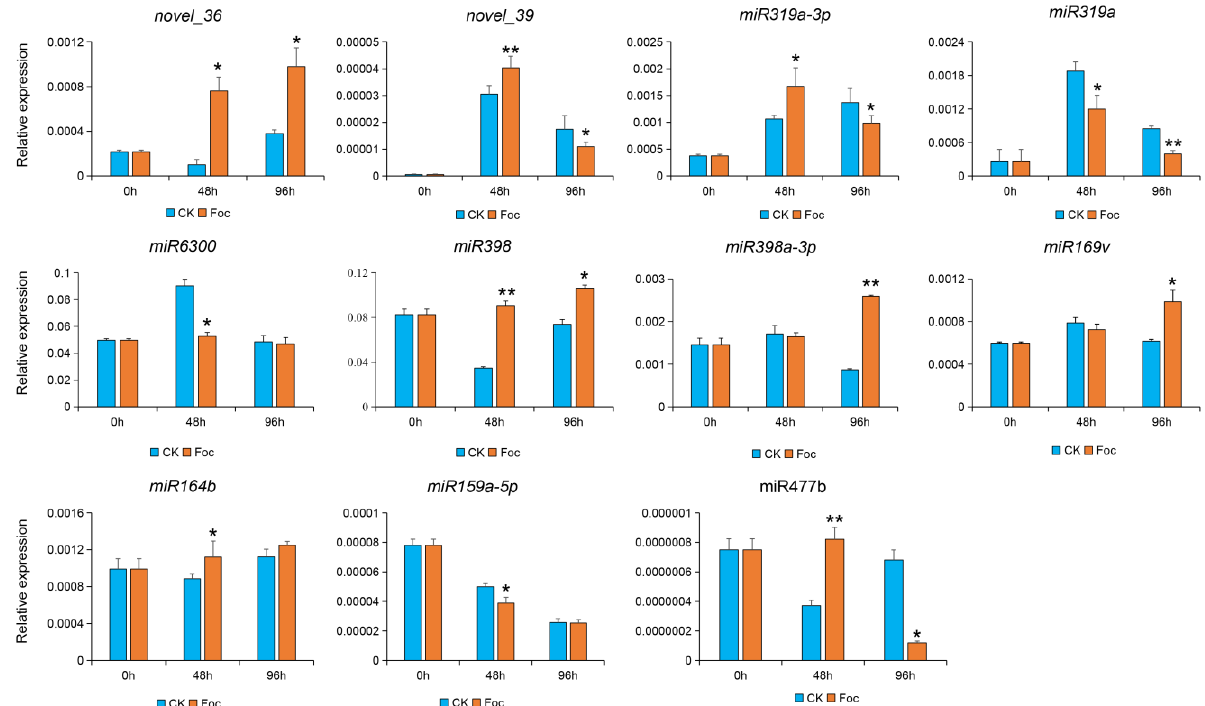
Figure 2. Validation of 11 DEMs in cucumber roots infected with Foc by stem-loop qPCR. Relative miRNA expression levels in the Foc-inoculated cucumber roots and the mock-inoculated control roots at 48 and 96 h post-inoculation were calculated according to the 2 −ΔCt method, with U6 snRNA used as the internal reference control. Data are presented as the mean ± standard deviation of three biological replicates. *: significantly different at p < 0.05; **: significantly different at p < 0.01.